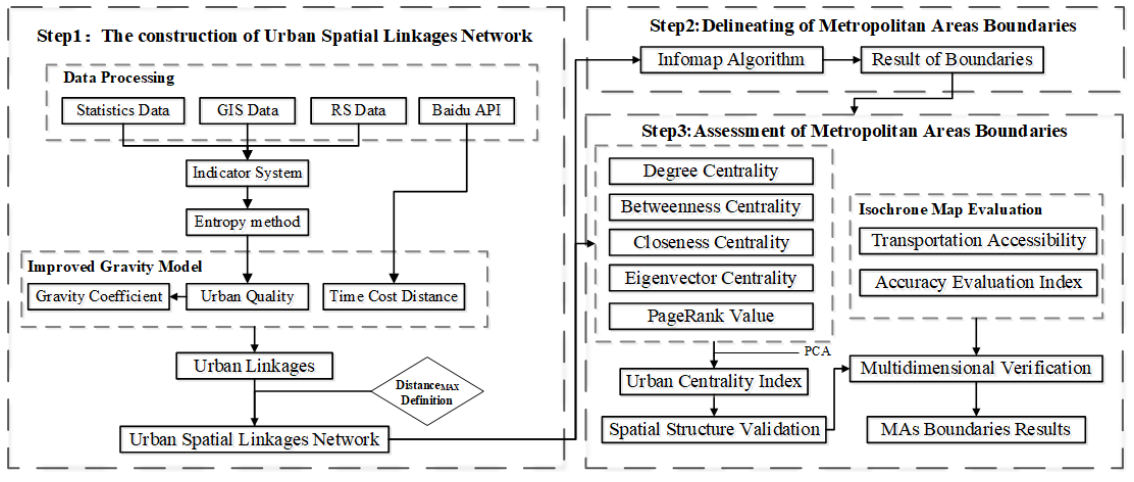
Figure 2. Methodology flow diagram of this study.